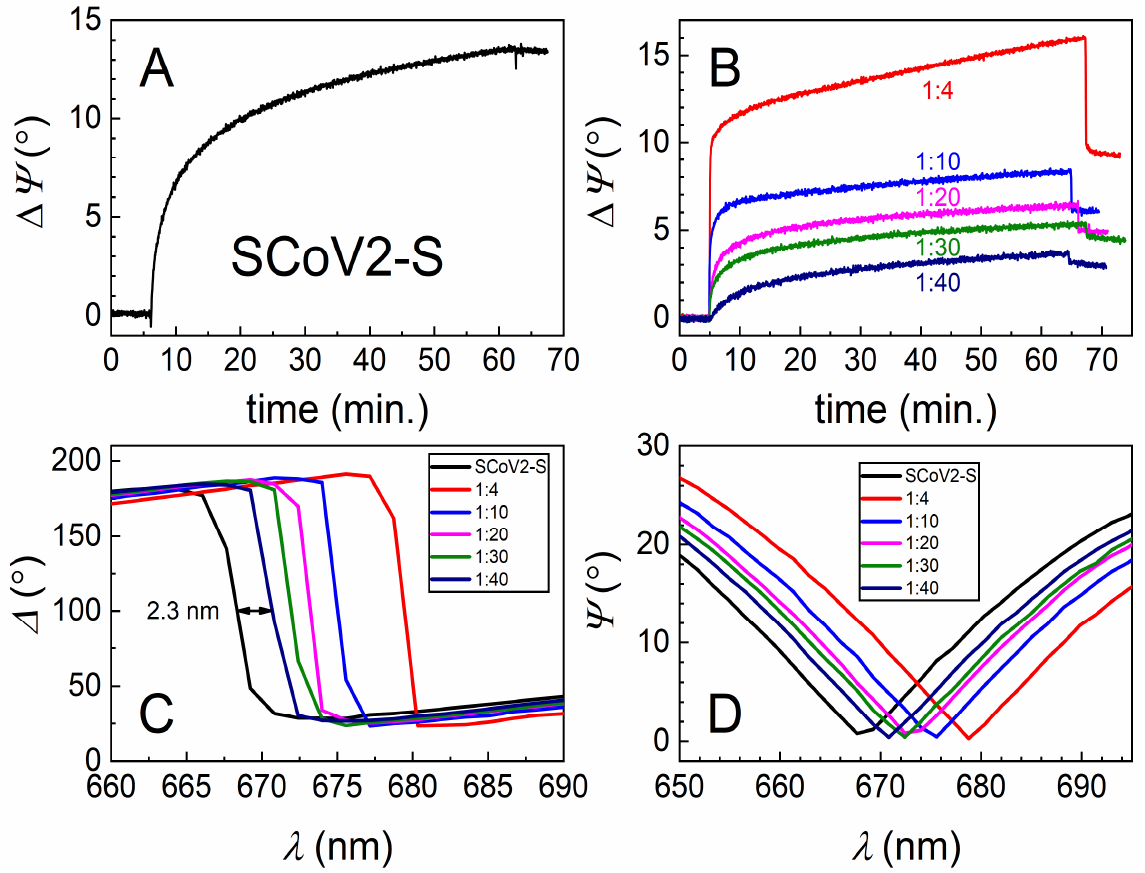
Figure 2. Time-resolved TIRE kinetics and ellipsometric parameters of SCoV2-S immobilization and interaction with specific polyclonal antibodies. ( A ) Kinetics of covalent SCoV2-S immobilization on 11-MUA SAM modified gold-coated SPR sensor disc; ( B ) kinetics of polyclonal antibody interaction with covalently immobilized ScoV2-S at different serum dilutions (1:4, 1:10, 1:20, 1:30, and 1:40); ( C ) ∆ and ( D ) Ψ spectral shift after immune complex formation using the same dilutions of polyclonal antibodies.